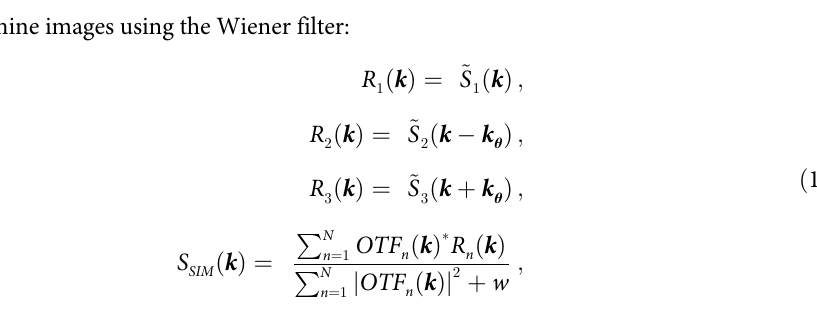
in the angular direction of θ = 0˚, 60˚, 120˚, respectively. θ